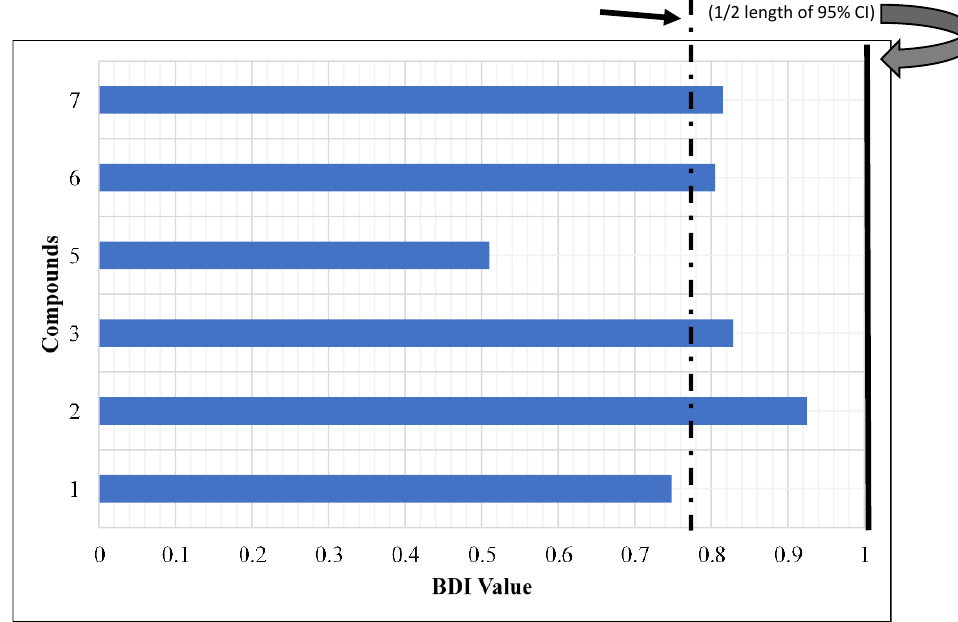
Figure 4. Mean biting deterrence index (BDI) values of the pure compounds purified from active fractions of methanolic extract of Stenaria nigricans against female Aedes aegypti . Ethanol was the solvent control and DEET at 25 nmol/cm 2 was used as the positive control.